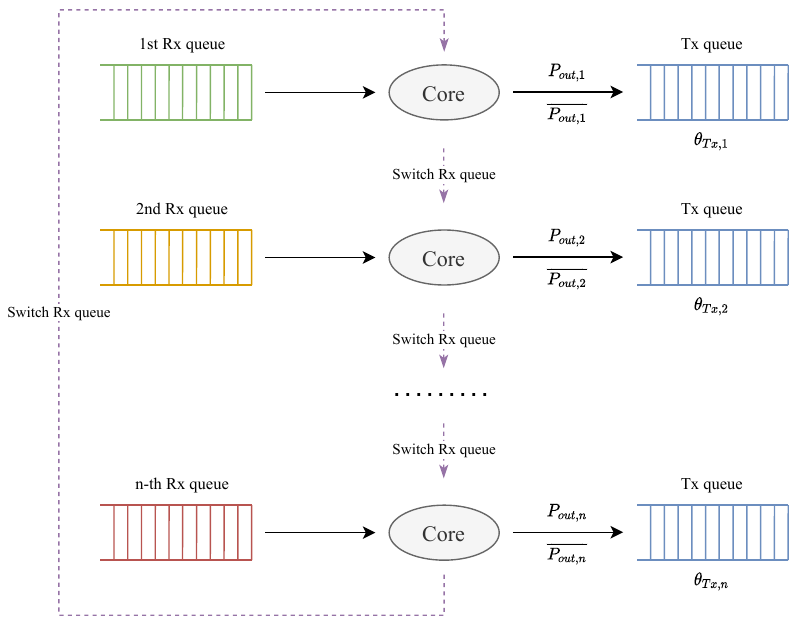
Figure 9. The multiple Rx queues.